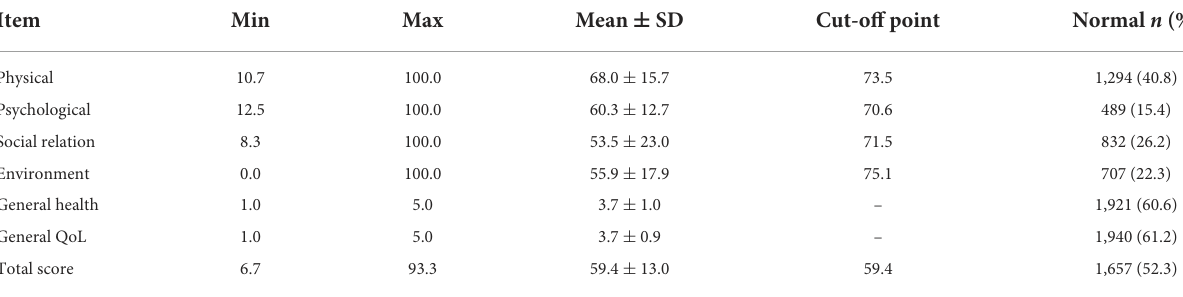
TABLE 2 Summary of the quality-of-life scores from WHOQoL-BREF domains.